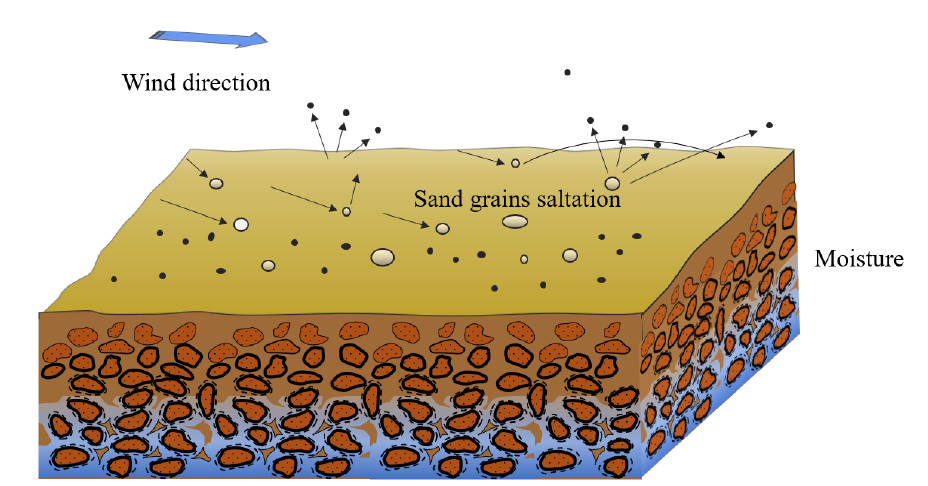
Figure 1. Schematic diagram of sand-bed collision in aeolian sand transport. Sand grains move forward in nearly ballistic trajectories, collide with the loose sand surface and eject new sand particles. Surface moisture enhances the cohesive forces among sand particles and sand particles saltate higher